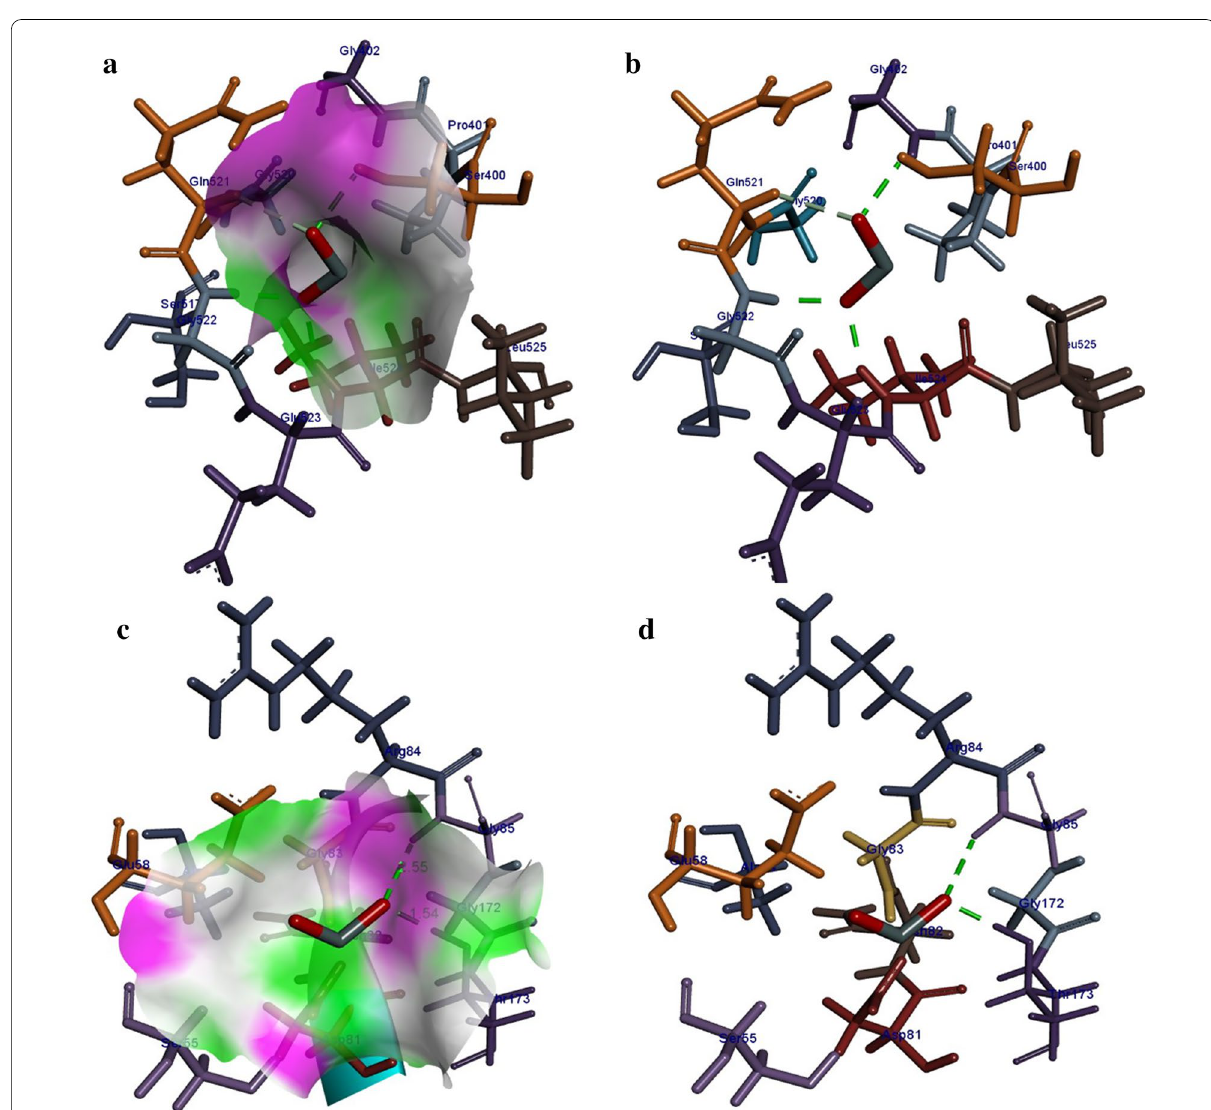
Fig. 13 a , b Binding interaction pattern of SnO 2 nanoparticle with active site residues of β ‑lactamase and c , d DNA gyrase from S.